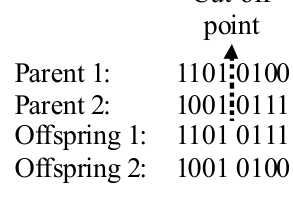
Figure 4. Crossover Operation Fig. 4. Crossover Operation.